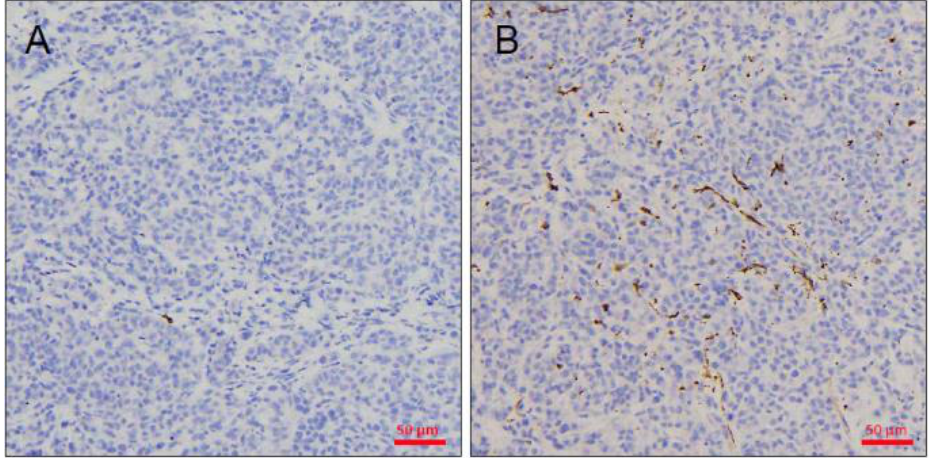
Figure 4. To confirm lymphomatous transformation in PDX tumors, immunohistochemical staining for analysis of CD3 ( A ), and CD20 ( B ) expression were performed. The tumor cells were CD3-negative and CD20-negative, indicating there were no lymphomatous transformation in PDX tumors. Bar = 50 μm.